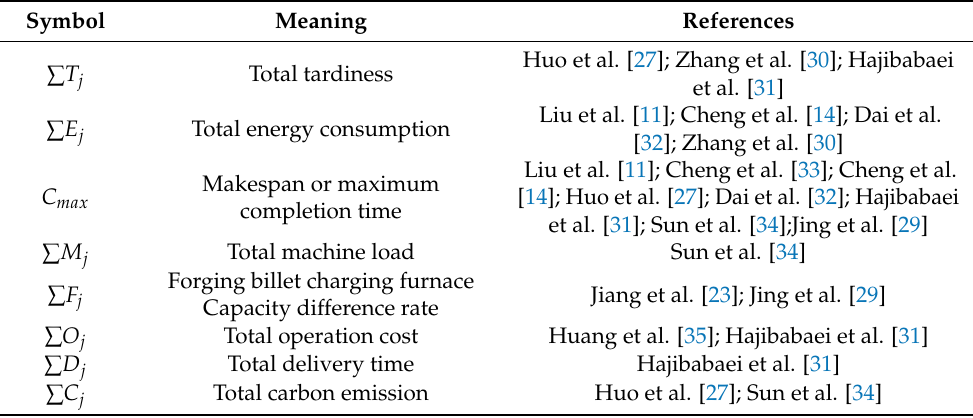
Table 1. Document arrangement for the optimization target of forging thermoforming produc- tion